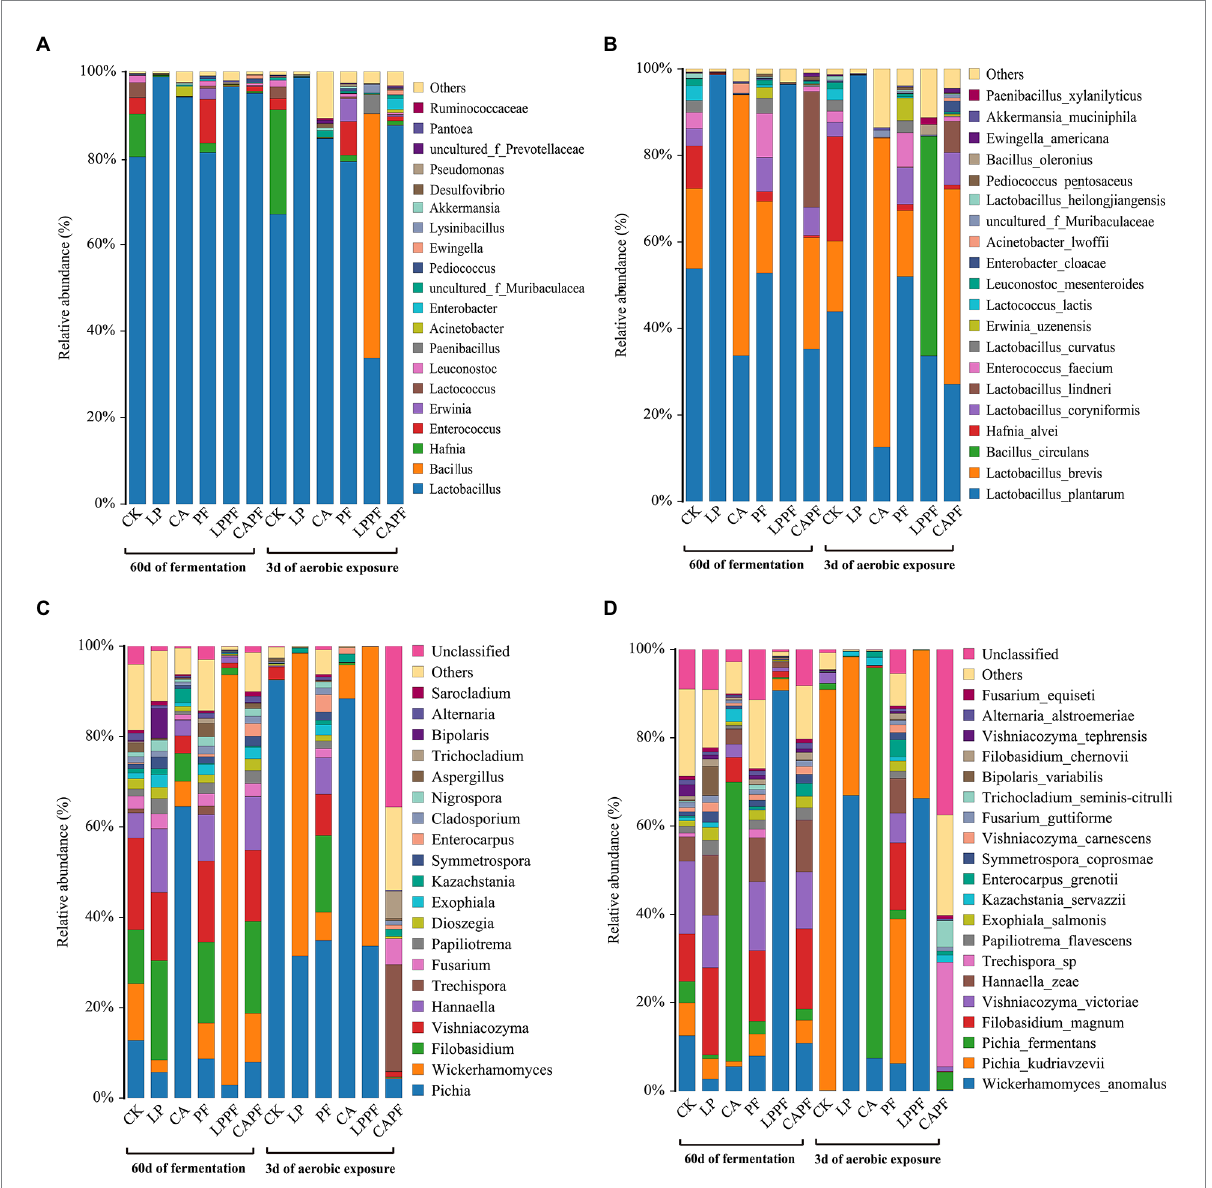
FIGURE 3 Relative abundances of the silage bacterial and fungal composition. Bacteria at genus level (A) , and species levels (B) ; fungal at genus level (C) , and species levels (D) ; CK, control; LP, Lactobacillus plantarum a214; CA, citric acid; PF, purple perilla; LPPF, purple perilla + Lactobacillus plantarum a214; CAPF, purple perilla + citric